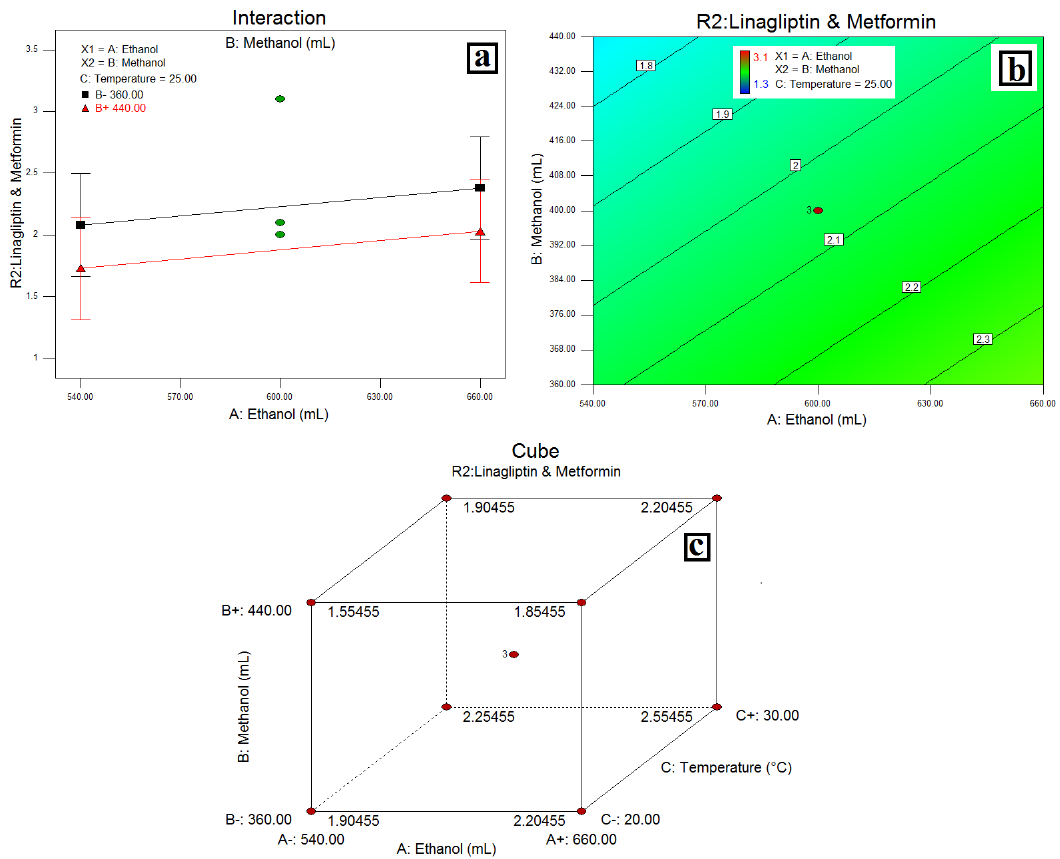
Figure 5. ( a ) Interaction of MeOH and EtOH on resolution of LGP and Met HCl; ( b ) Desirability Plot and ( c ) cube showing the interaction of EtOH, MeOH and temperature.